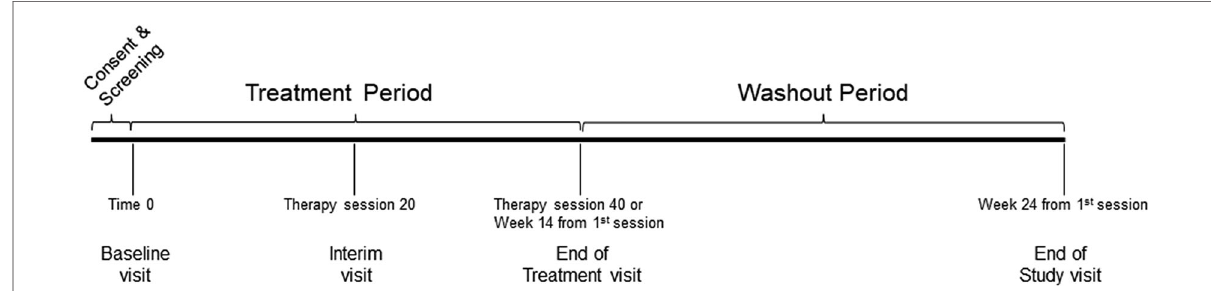
FIGURE 1 Study design and timeline. The baseline visit was considered Time 0 and randomization occured within three days after the visit. The treatment period included forty therapy sessions that had to be completed in a time window of no more than fourteen weeks from the fi rst therapy session. The washout period was from the last therapy until twenty-four weeks from the fi rst therapy